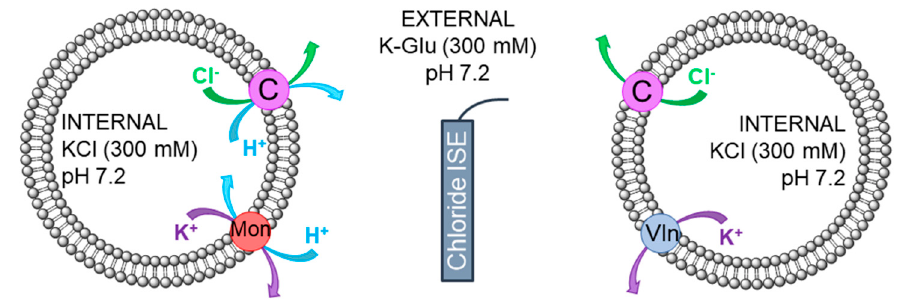
Figure 3. Overview of the complementary cationophore coupled assay. POPC vesicles (grey) contain an internal KCl (300 mM) solution and are suspended in an external K-Glu (300 mM) solution both buffered to pH 7.2 with HEPES. KCl efflux monitored by a chloride ISE (navy) induced by valinomycin (Vln, blue) facilitated electrogenic K + transport coupled to compound (C, purple) mediated Cl − uniport (right), and monensin (Mon, red) facilitated electroneutral K + /H + exchange coupled to compound (C, purple) mediated Cl − /H + symport